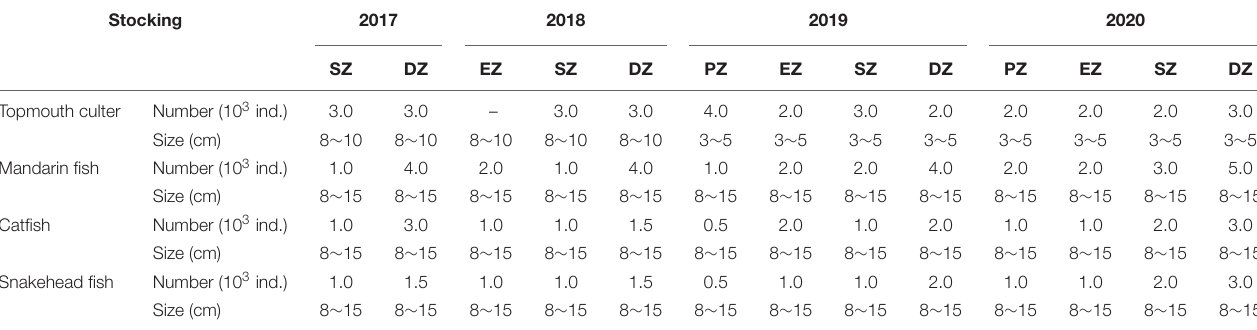
TABLE 2 | The total number and individual size of piscivorous fish species stocked annually into the four purification zones of Lake Yanlong (PZ, the pretreatment zone; EZ, the emergent macrophyte zone; SZ, the submerged macrophyte zone; DZ, the deep purification zone) from 2017 to 2020.